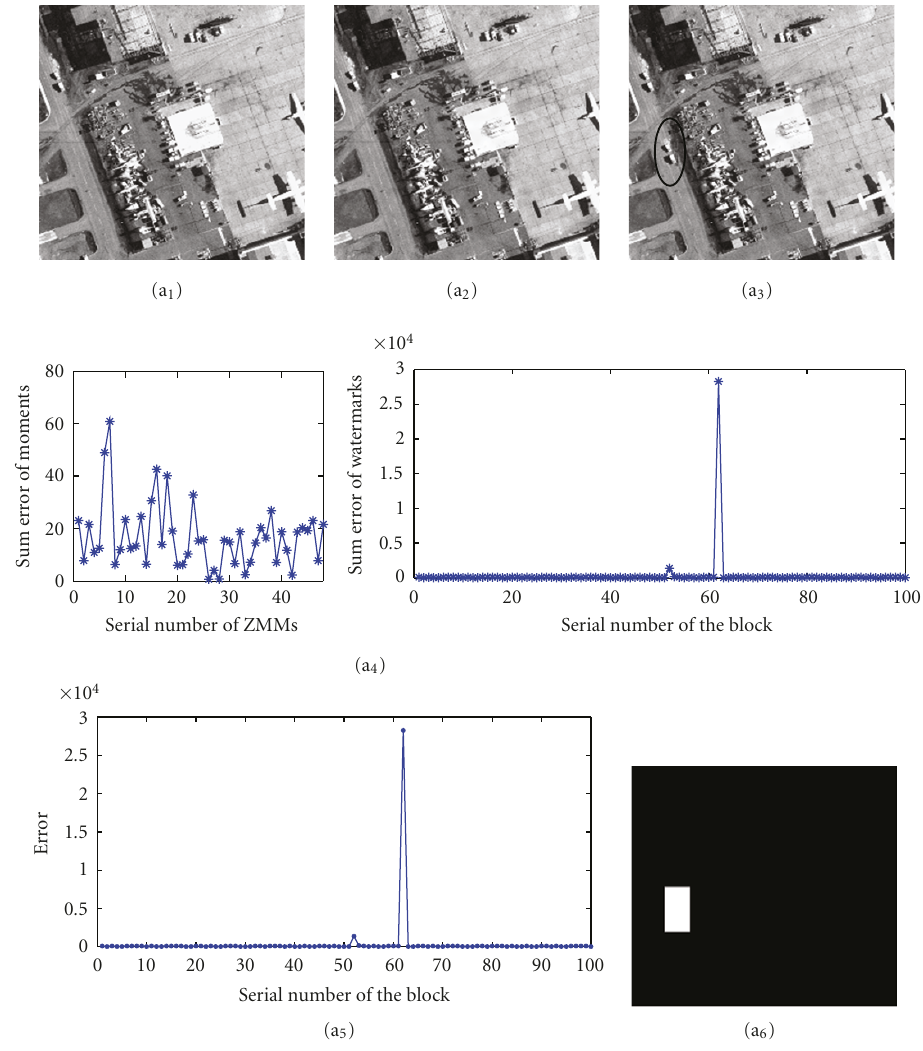
Figure 7: Demonstration of the location method of the attacked